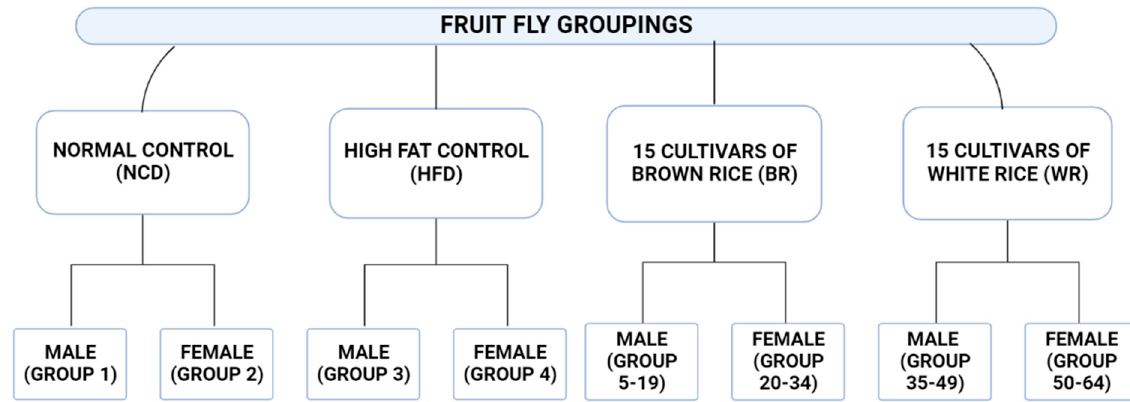
Figure 7. Fruit fly